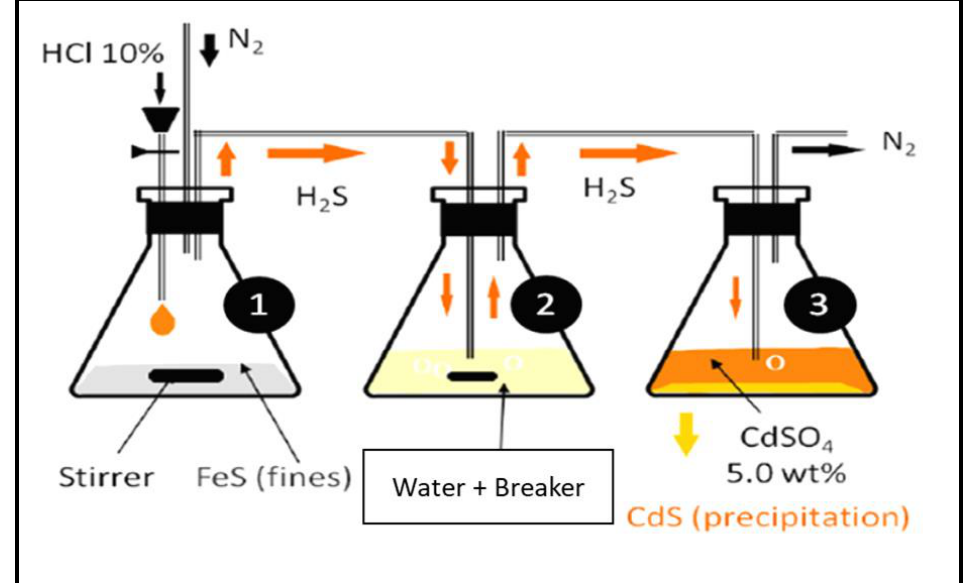
Figure 3. Sour environment compatibility experiment setup.